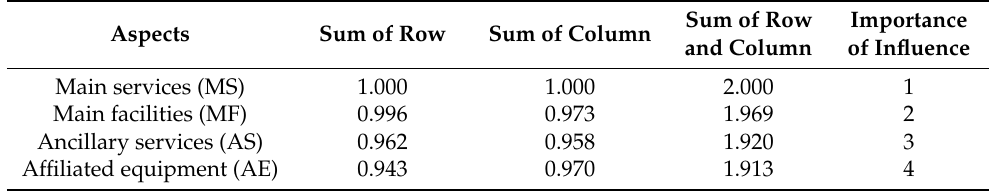
Table 4. The comparison table of the direct influence